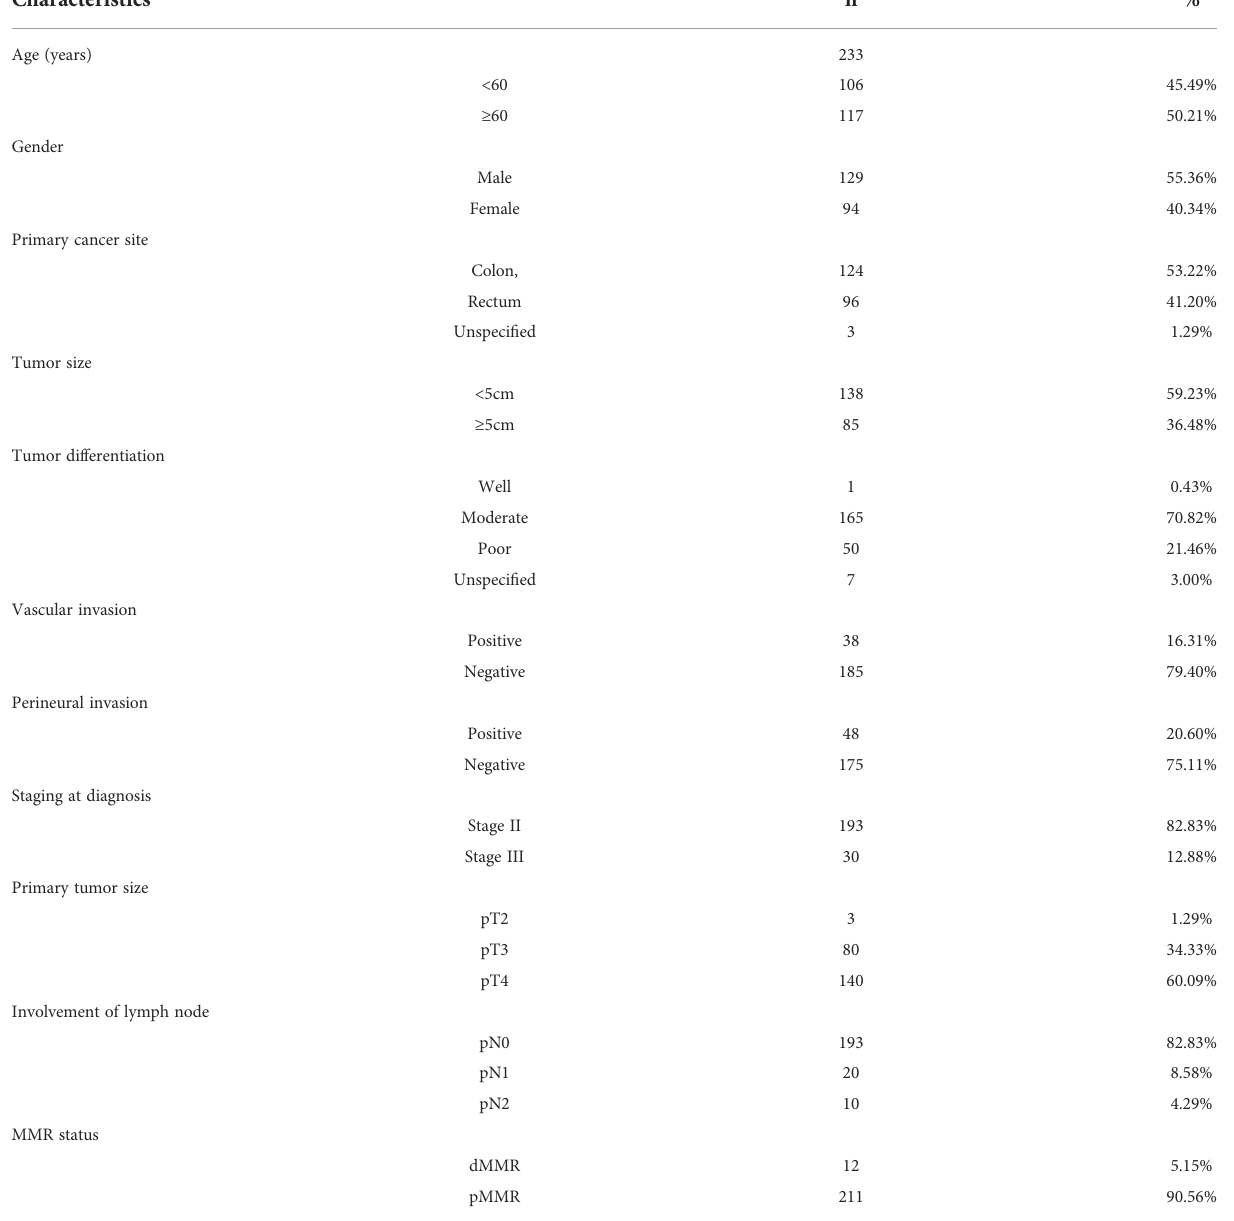
TABLE 1 Clinicopathological features of colorectal cancer patients.